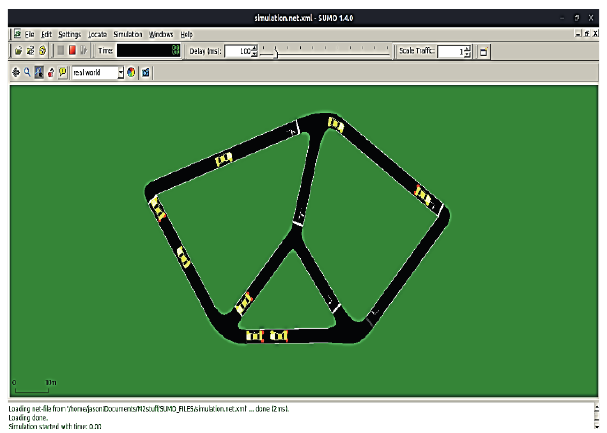
Fig. 9. Visualisation of the map using SUMO.